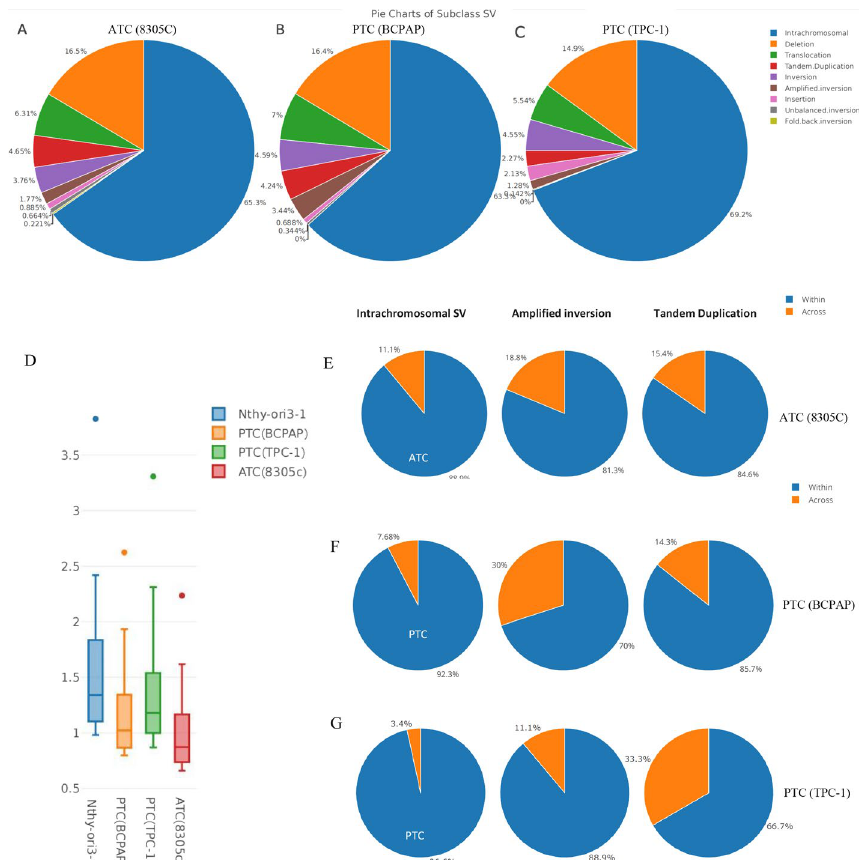
Fig. 4 A – C SV subtypes identified on the basis of WGS. The distribution of SV subtypes in A ATC (8305C), B PTC (BCPAP), and C PTC (TPC-1) cells. SVs were identified by DELLY2. D Differences in TAD changes between ATC (8305C), PTC (BCPAP and TPC-1), and normal thyroid cell lines. The ratio of short-range to long-range TAD blocks in ATC, PTC, and normal cell-lines. E – G SV breakpoints associated with TAD boundaries. The distribution of SV subtypes across (span-SV) or within nearest TAD boundaries (within-SV) in E ATC (8305C), F PTC (BCPAP), and G PTC (TPC-1)